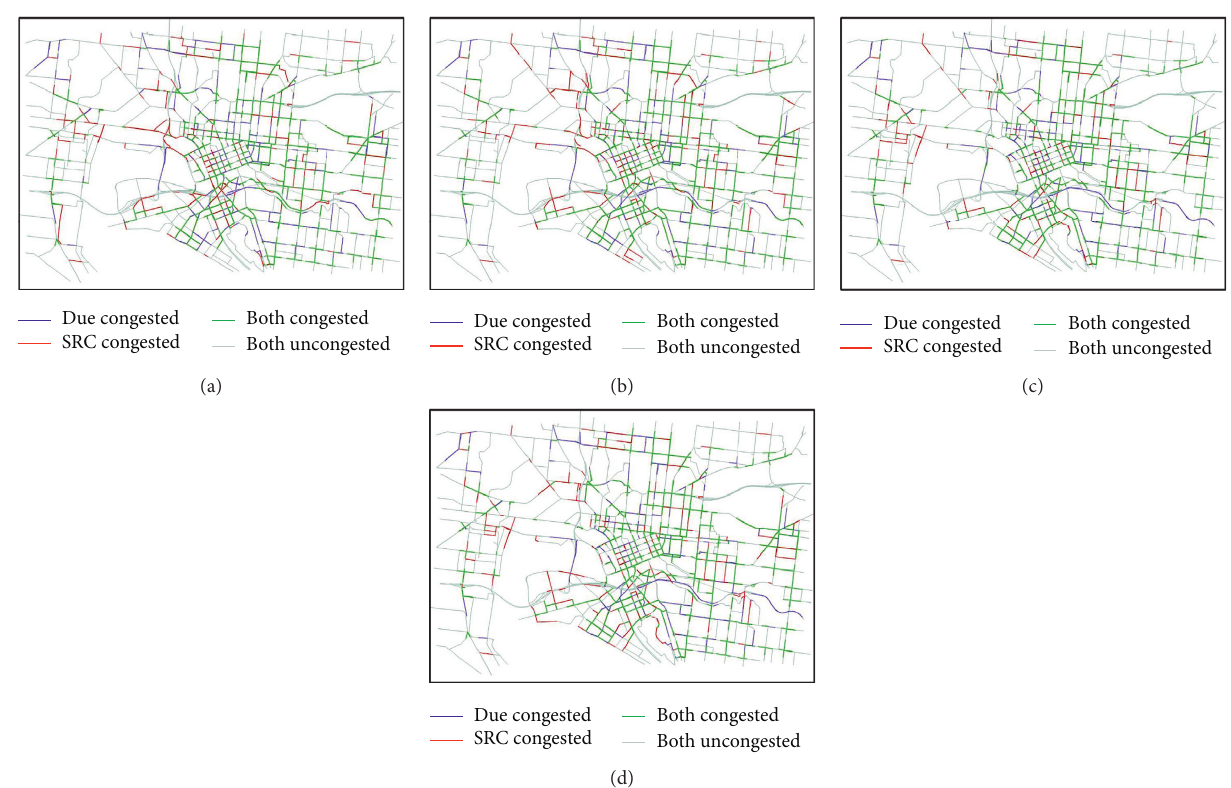
Figure 10: Spatial visualization of congestion patterns in the network at 08:00AM when ρ � 0 . 5: comparison of the SRC and DUE model outcomes with varying levels of adaptive drivers (a) 0%, (b) 20%, (c) 60%, and (d) 80%. Congested (uncongested) refers to the case in which a link in the network is estimated to be congested (uncongested) in both the DUE and SRC models, while DUE congested and SRC congested refer to the cases in which the link is estimated to be congested in DUE or SRC alone,